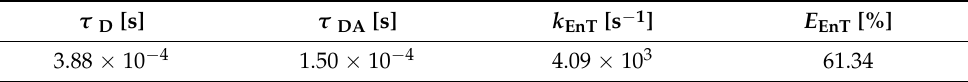
Table S3: Hydration state of Tb 3+ ( q Tb ) and Eu 3+ ( q Eu ) in Tb-PhPOSS and TbEu-PhPOSS,